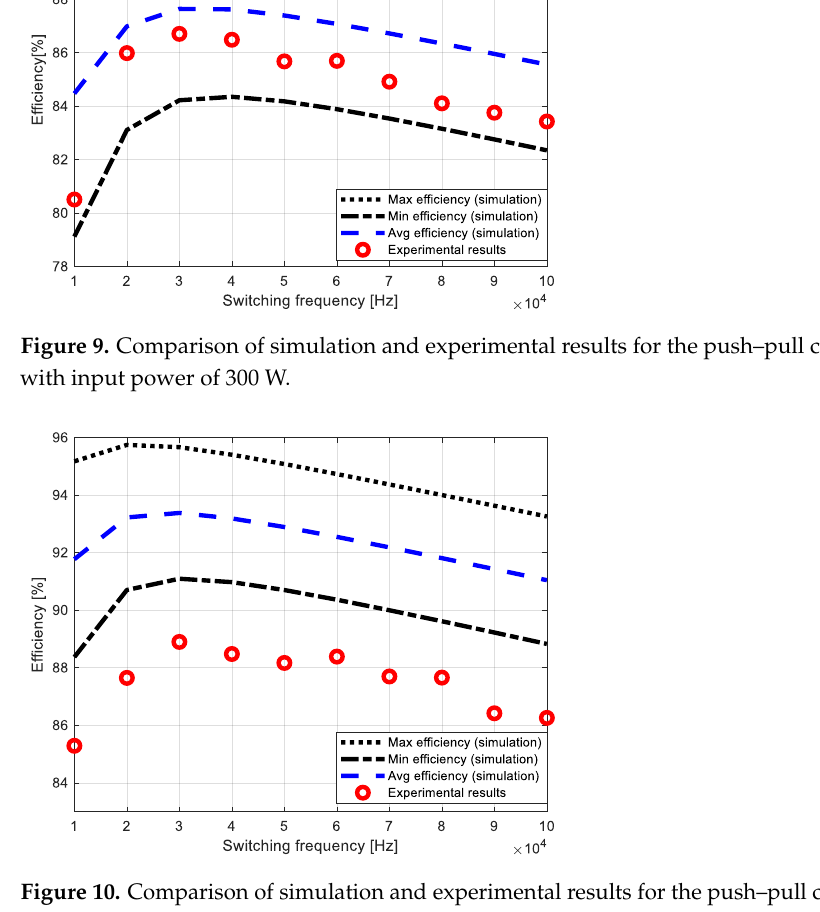
Figure 10. Comparison of simulation and experimental results for the push–pull converter efficiency with input power of 150 W.